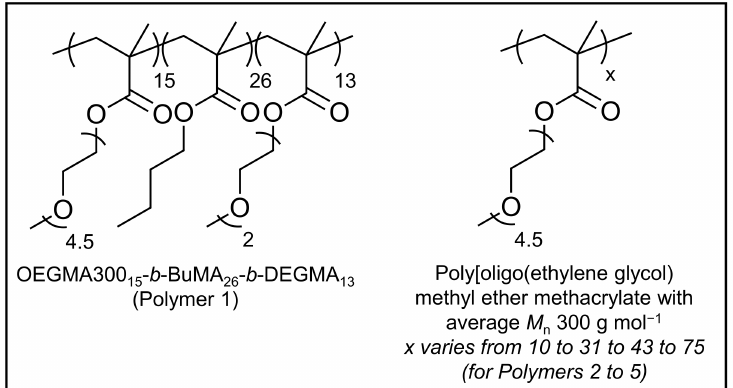
Figure 1. Chemical structures of the polymers; OEGMA300, BuMA, and DEGMA stand for oligo(ethylene glycol) methyl ether methacrylate with average M n 300 g mol − 1 , n -butyl methacrylate, and di(ethylene